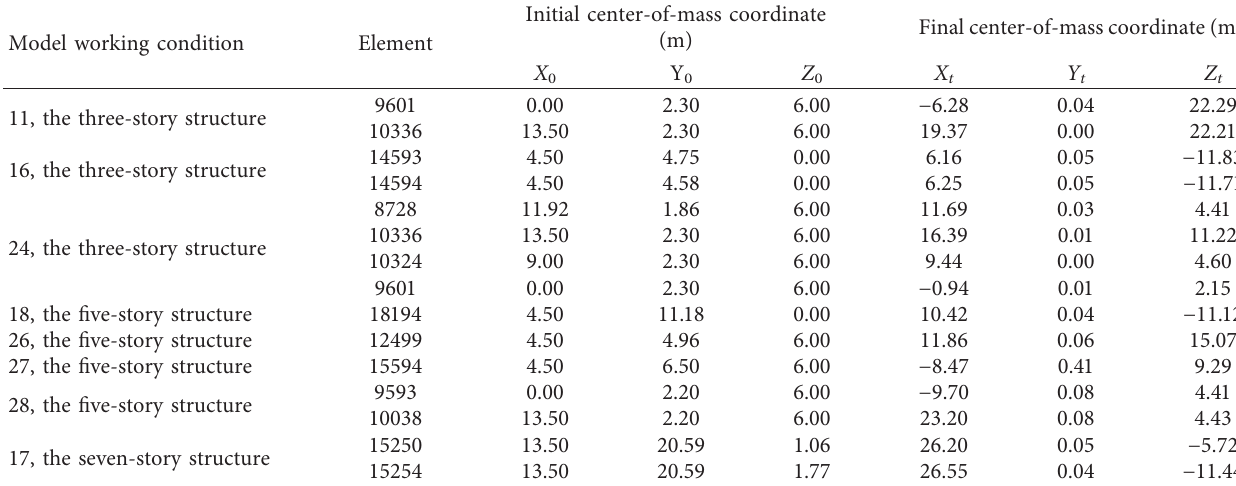
Figure 17: Time-displacement curve of the flying stone elements. (a) The direction along the X axis, (b) the direction along the Y axis, and (c) the direction along the Z axis. Table 4: The initial and final center-of-mass coordinates of the effective flying stones